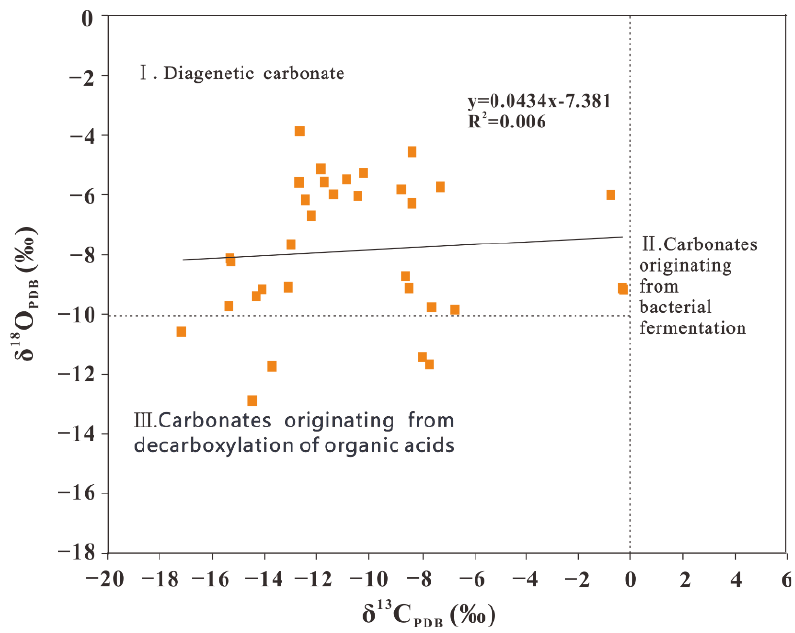
Figure 2. Carbonate origin analysis diagram [55] based on carbon and oxygen isotope values.